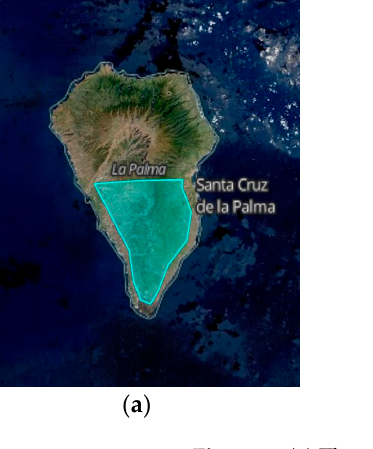
Figure 9. ( a ) The area under study for the MODIS LST analysis. ( b ) LST time series analysis for pixels in the region indicated in Figure 9b. MODIS data was downloaded from [51].